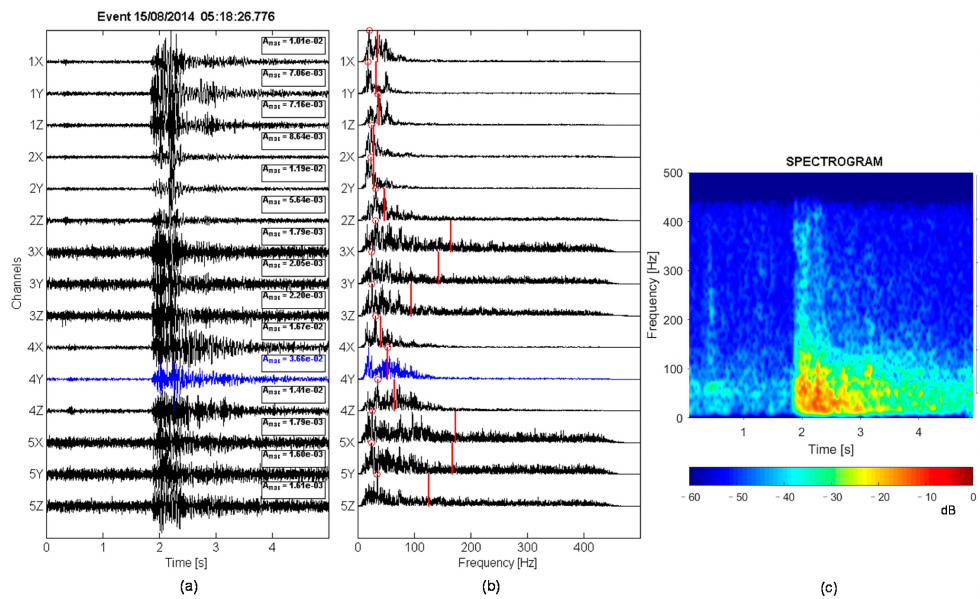
Figure 2. Example of microseismic (MS) events likely related to fracture propagation. ( a ) Signals recorded by 15 channels (with 5 three-component geophones) with the maximum absolute amplitude written inside the rectangle. The channel in blue color has the maximum absolute amplitude among all 15 channels. ( b ) Fourier spectra (red circles and red vertical lines present the positions of the peak and centroid of the amplitude spectrum in the channels, respectively). ( c ) Spectrogram generated by stacking the spectrograms of all channels.